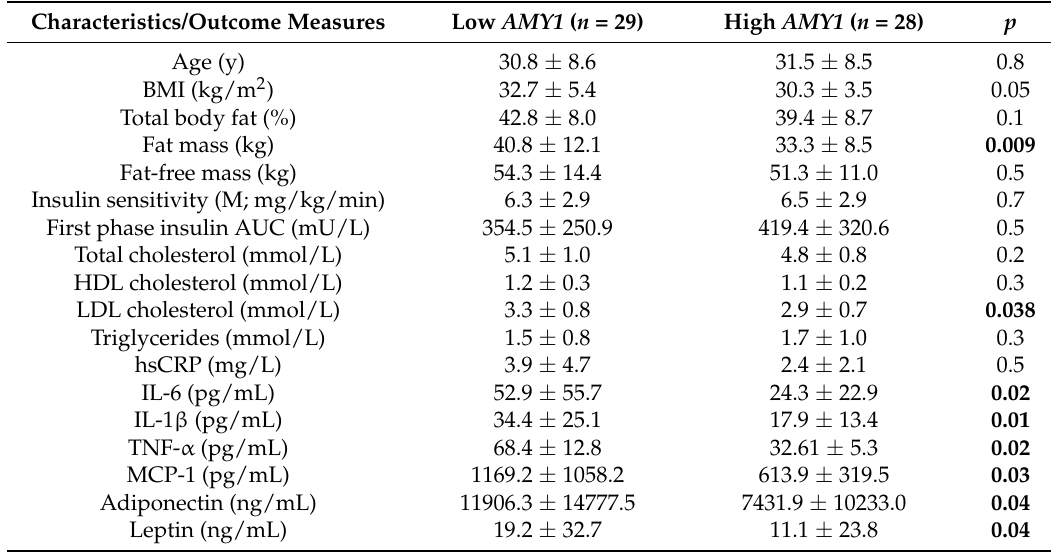
Table 1. Demographic, clinical, and biochemical characteristics of participants within low and high AMY1 CNV